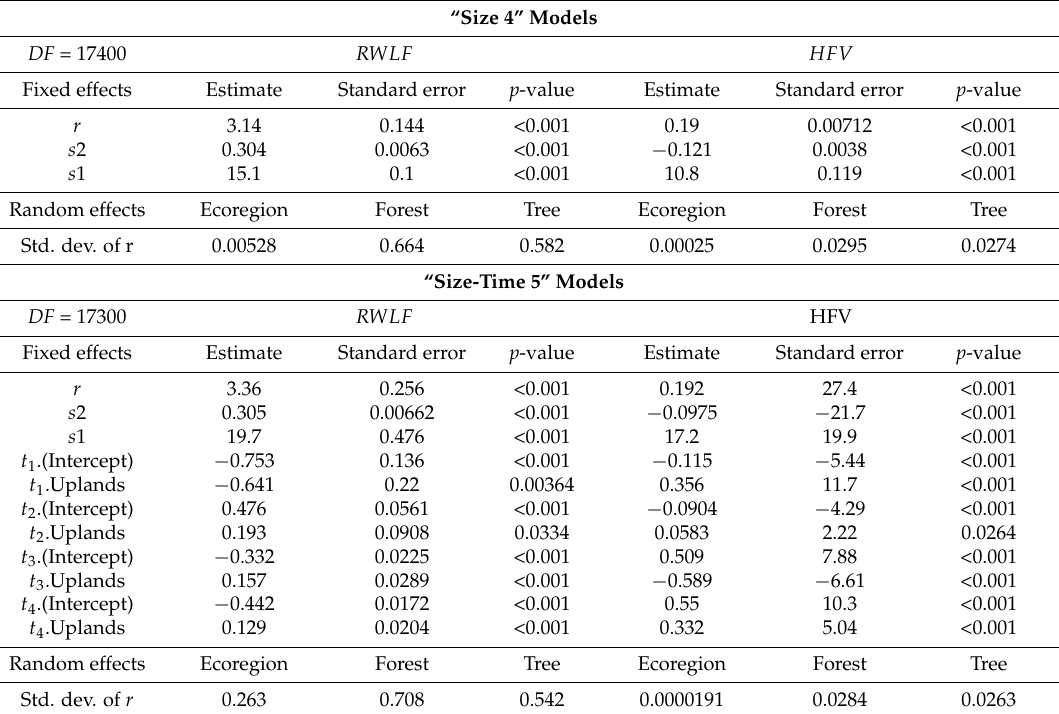
Table 2. Parameter estimates of the “size 4” models (top) and “size-time 5” models (bottom) for ring-width low frequency ( RWLF , left) and for high-frequency variability ( HFV ,